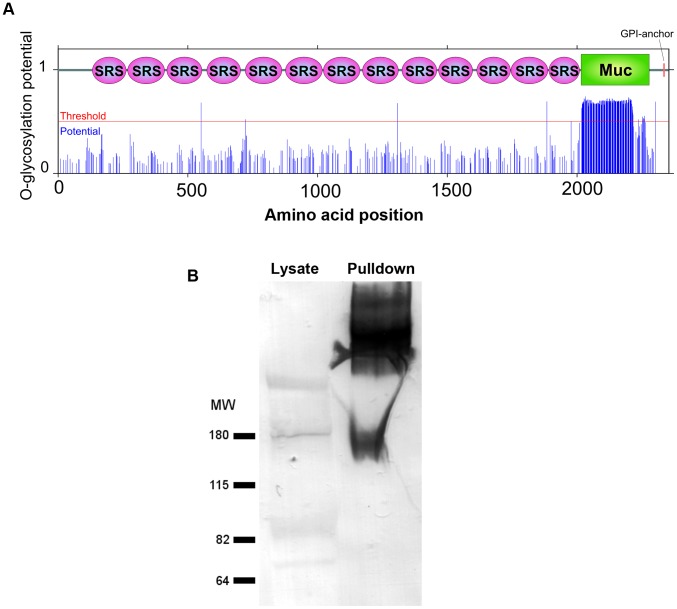
The mucin domain of CST1 is highly O-glycosylated.(A) The glycosylation potential of CST1 was predicted by the NetOGlyc 3.1. Red line indicates the threshold and blue line indicates the potential at each S/T amino acid position with domain-scheme overlay. This method predicts that the mucin domain is likely to be highly O-glycosylated. (B) mAb SalmonE immunoprecipitates are bound by DBA lectin. The left lane is 10 µl of whole parasite lysate (ME49 at pH 8.1) and the right lane is the sample (equivalent to 200 µl lysate) that was immunoprecipitated with mAb SalmonE, separated by SDS-PAGE and transferred to nitrocellulose membrane. The membrane was probed with AP-conjugated DBA lectin.